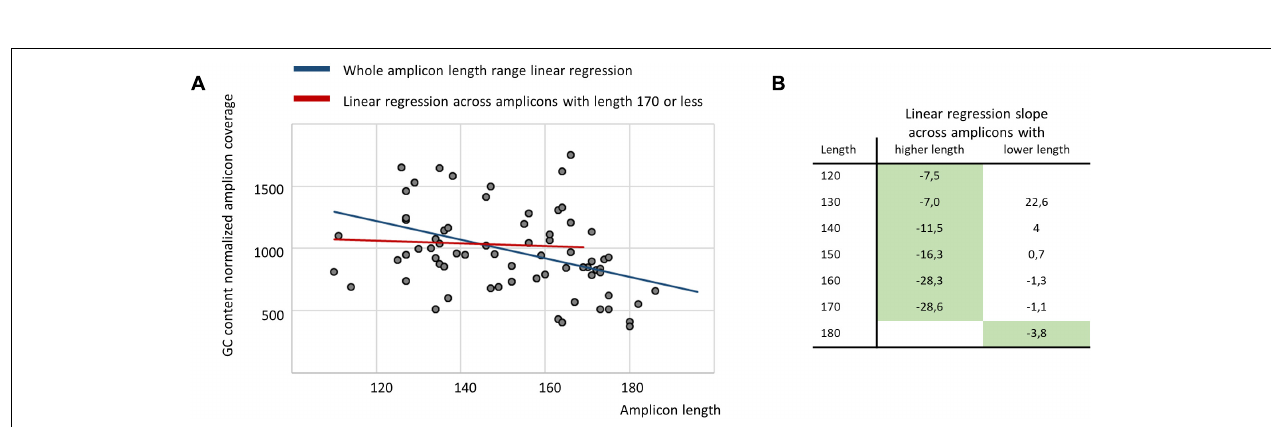
FIGURE 3 | Pairwise comparison of the frequencies for same mutated allele in reads obtained from pairs of panel-specific amplicons across detected somatic variants.